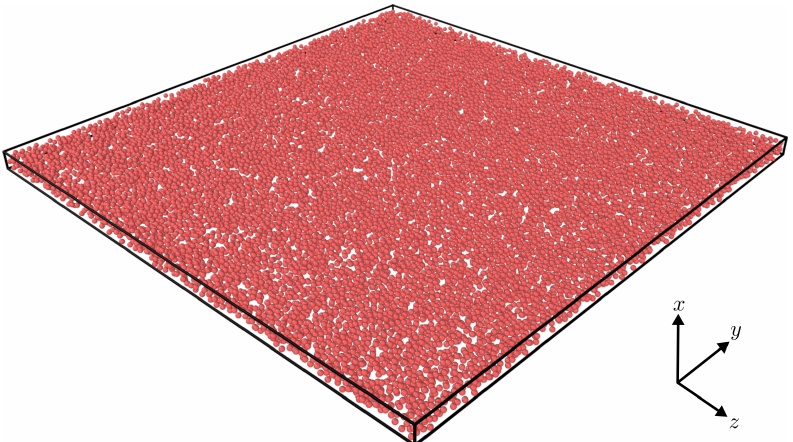
Figure 1. Visualization of the fluid particles in a slit pore of height L x = 4 σ , chemical potential µ ∗ = 1, and temperature T ∗ = 2. The fluid particles are rendered in red, and their diameter is rendered at σ . The solid is not rendered. The solid lines illustrates the edges of the simulation box. The simulation was rendered with Open Visualization Tool (OVITO)